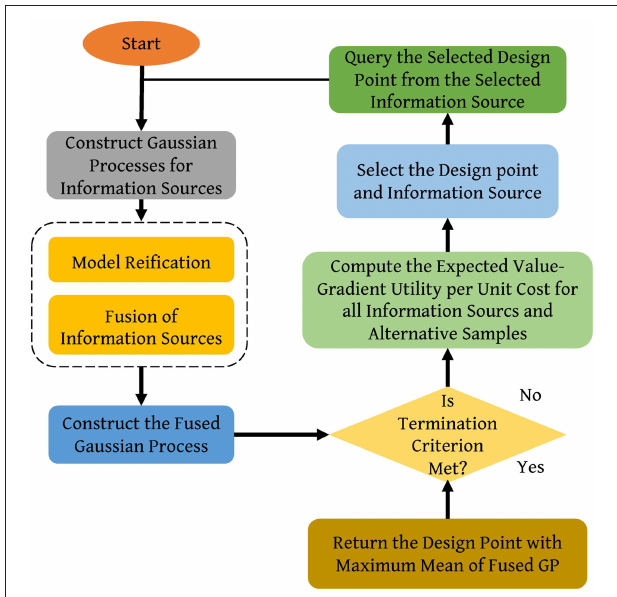
FIGURE 3 | Flowchart of the information fusion approach. Adapted from Ghoreishi et al. (2018).